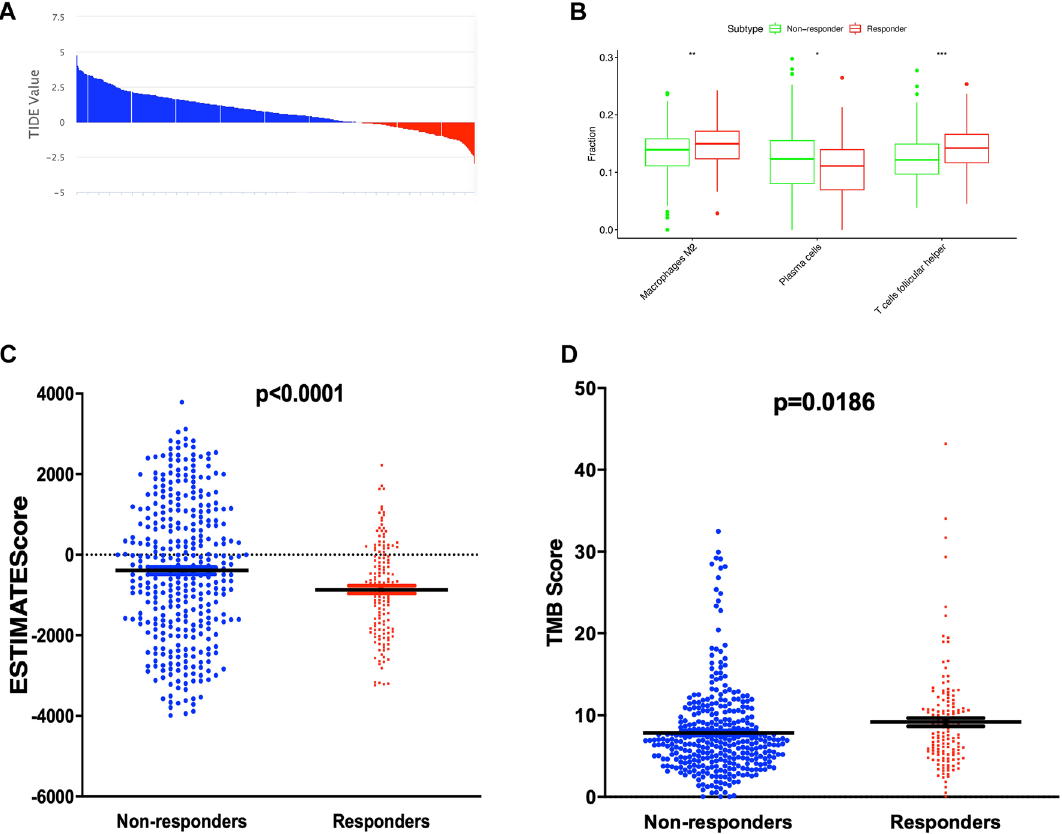
Figure 2. The immune-related characteristics between responder and non-responder. ( A ) 502 LUSC patients were divided into responder (red) and non-responder (blue) groups by the TIDE algorithm. ( B ) Boxplot showed the ratio differentiation of 3 kinds of immune cells between responder and non-responder groups. ( C ) Different ESTIMATE Score between responder and non-responder groups. ( D ) Different TMB score between responder and non-responder groups. * p < 0.05, ** p < 0.01, and *** p <